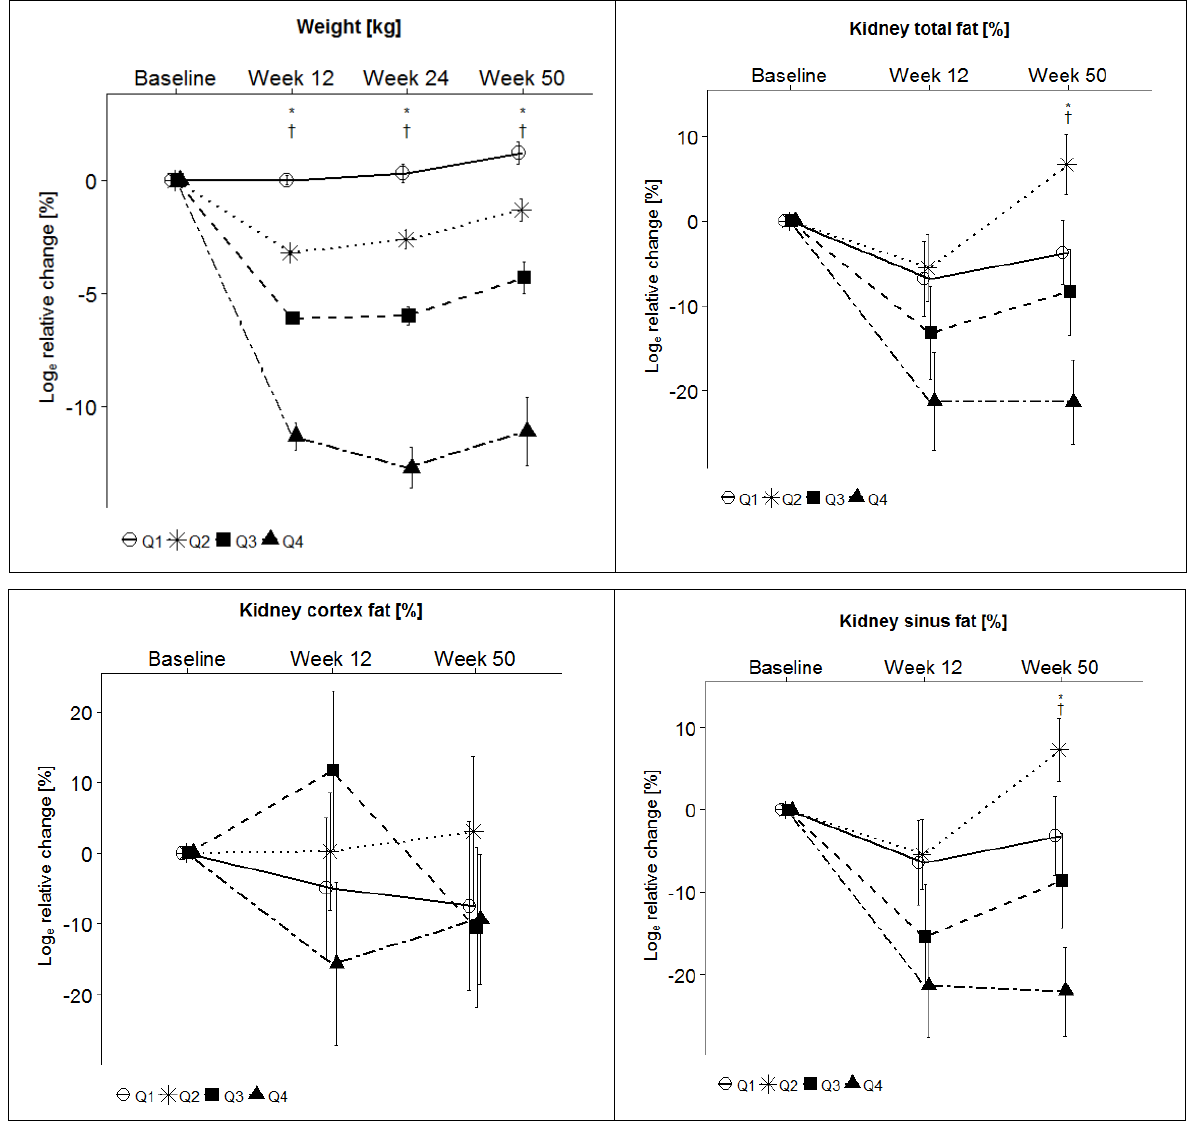
Figure 2. Relative changes of weight, total kidney fat content, kidney cortex fat content and kidney sinus fat content, n = 137. Data are shown as mean ± SEM for Log relative change. The baseline values serve as reference. Abbreviations: SEM, standard error of the mean; †, significant between the extreme quartiles 1 and 4; *, significant for all quartiles. The figure of weight change was published previously [21,34].